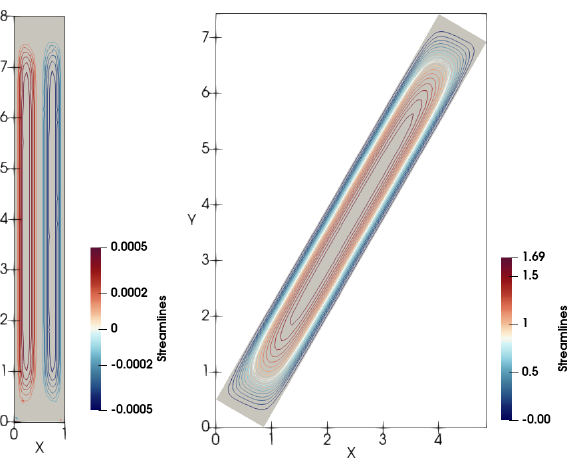
Figure 12. Streamlines of the mean volume velocity v for the vertical and inclined cells in the case of non-Newtonian